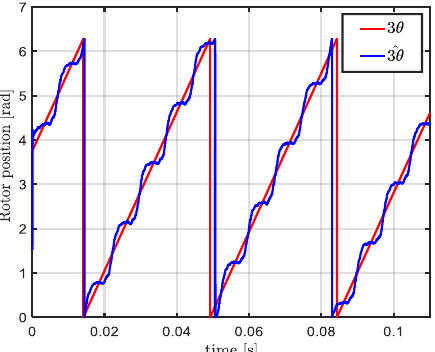
( c ) Figure 9. Simulation waveforms of actual and estimated back EMFs in the α -axis: ( a ) the 1st har- monic in MM, ( b ) the 9th harmonic in SM, ( c ) the 3rd harmonic in TM. The back EMF estimation of t he 1st harmonic in Figure 9a is the same as that esti- mated with strategy S1 . As the SMO algorithm used for MM is the same regardless of the sensorless control strategy, this back EMF estimation is still accurate compared to the ac- tual one. However, it can be seen in Figure 9b,c that the estimated back EMF of the 9th and 3rd harmonics are disturbed and not accurate compared to the actual back EMF. This is potentially due to the impact of the 19th and 11th harmonics, which are pre- sent, respectively, in SM and TM, as shown in Figure 2. It should be noted that the impact